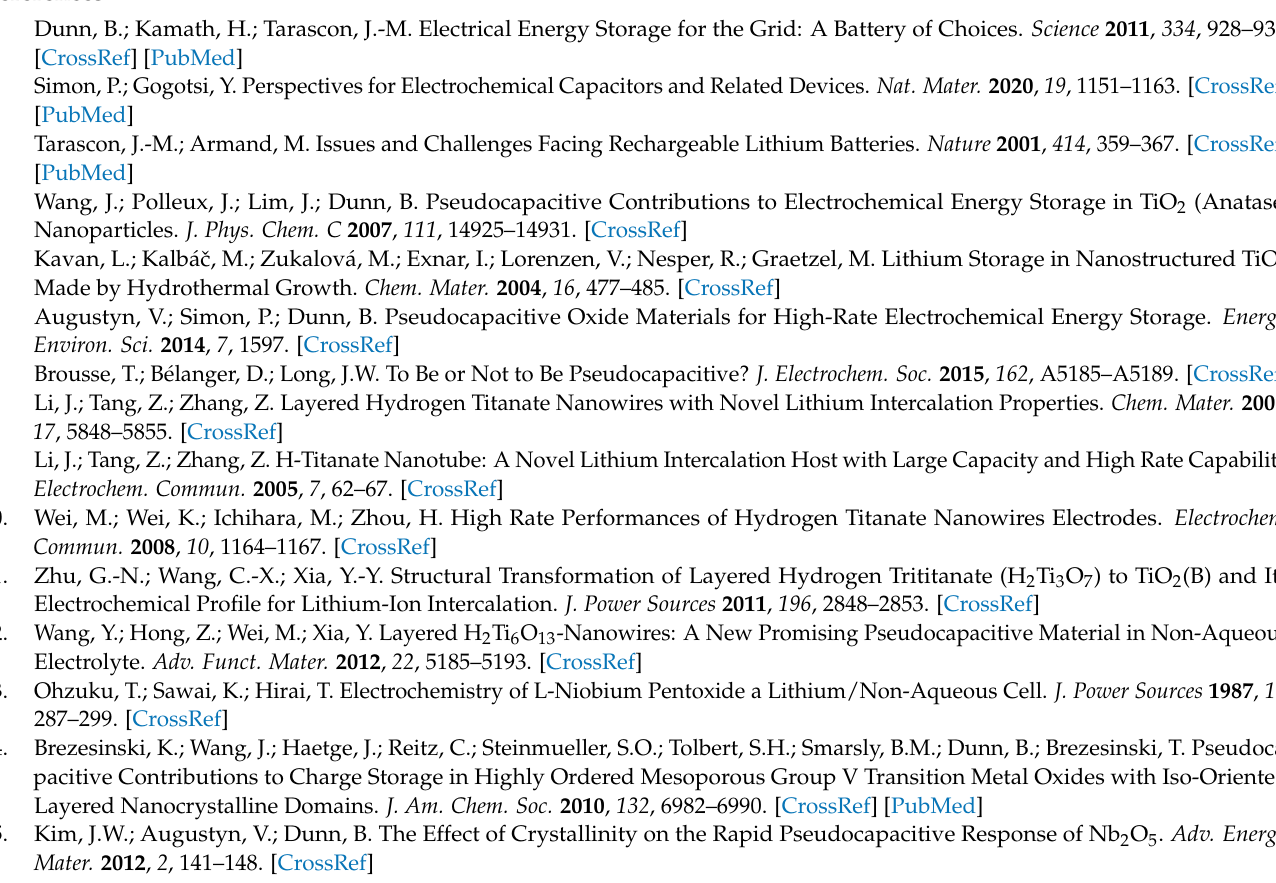
selected interatomic distances (Å), and bond valence sum calculations; Figure S4: Structure of the Li 0.167 WO 3.333 compound; Figure S5: (a) O3 atoms in the hexagonal cavity along the c-axis and O-O distances and (b) Li-O distances (distances in angstroms); Figure S6: Schematic of EQCM setup; Figure S7: Change of the motional resistance of Li-HTB on a Ti substrate in 5 M LiNO 3 at 10 mV.s − 1 ; Figure S8: (A) Homogeneously coated quartz and (B) CV of bare quartz vs. CV of coated quartz with Li HTB in 5M LiNO 3 at 10 mV.s − 1 ; Figure S9: Electrode drawing to be used in an operando cell for XAS; Figure S10: Operando XAS cell. (A) Scheme of the cell indicating the 3-electrode setup and (B) frontal view of the operando cell